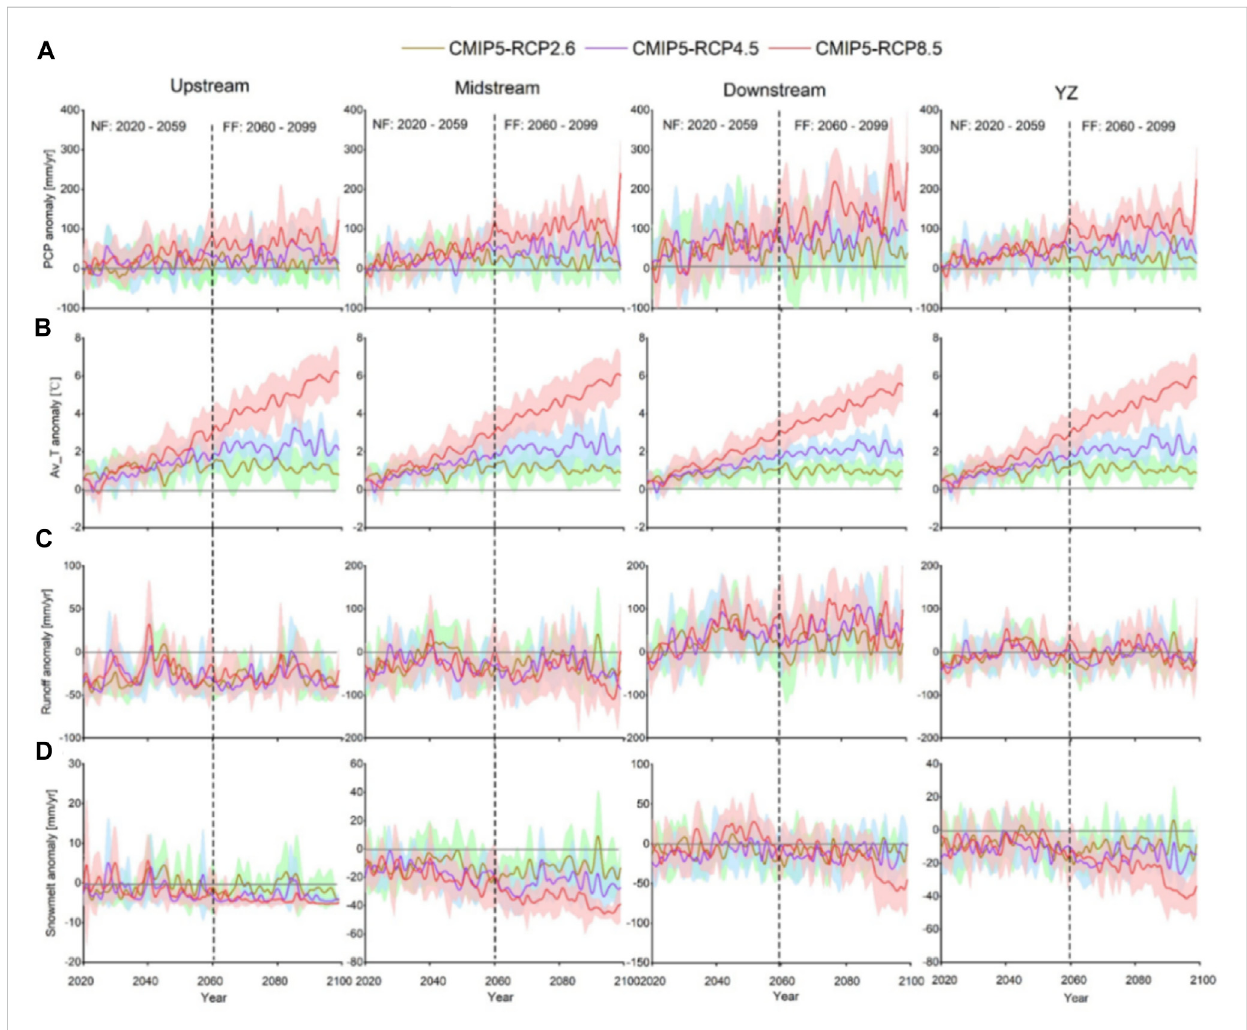
FIGURE 5 The anomalous statistics from the historical multi-year average of (A) average annual precipitation, (B) average temperature (Av_T), (C) runoff, and (D) snowmeltintheupstream,midstream,downstream,andYZBinthenearfuture(NF:2020 – 2059)andfarfuture(FF:2060 –